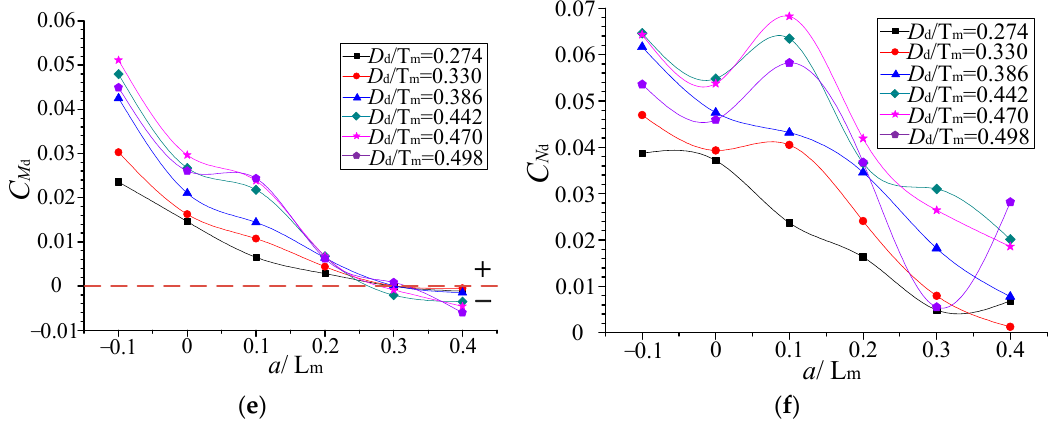
Figure 32. Influence of the longitudinal and vertical side ‐ hull locations on ( a ) C τ , ( b ) C Ra , ( c ) C Rd , ( d ) R d / R T , ( e ) C Md , and ( f ) C Nd .